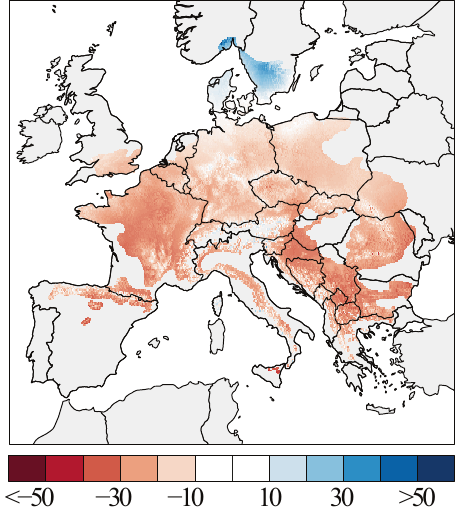
Fig. 3 The spatial pattern of beech growth changes across Europe. Tree growth changes are expressed in percent BAI change from 1986 to 2016 relative to the 1955 – 1985 period